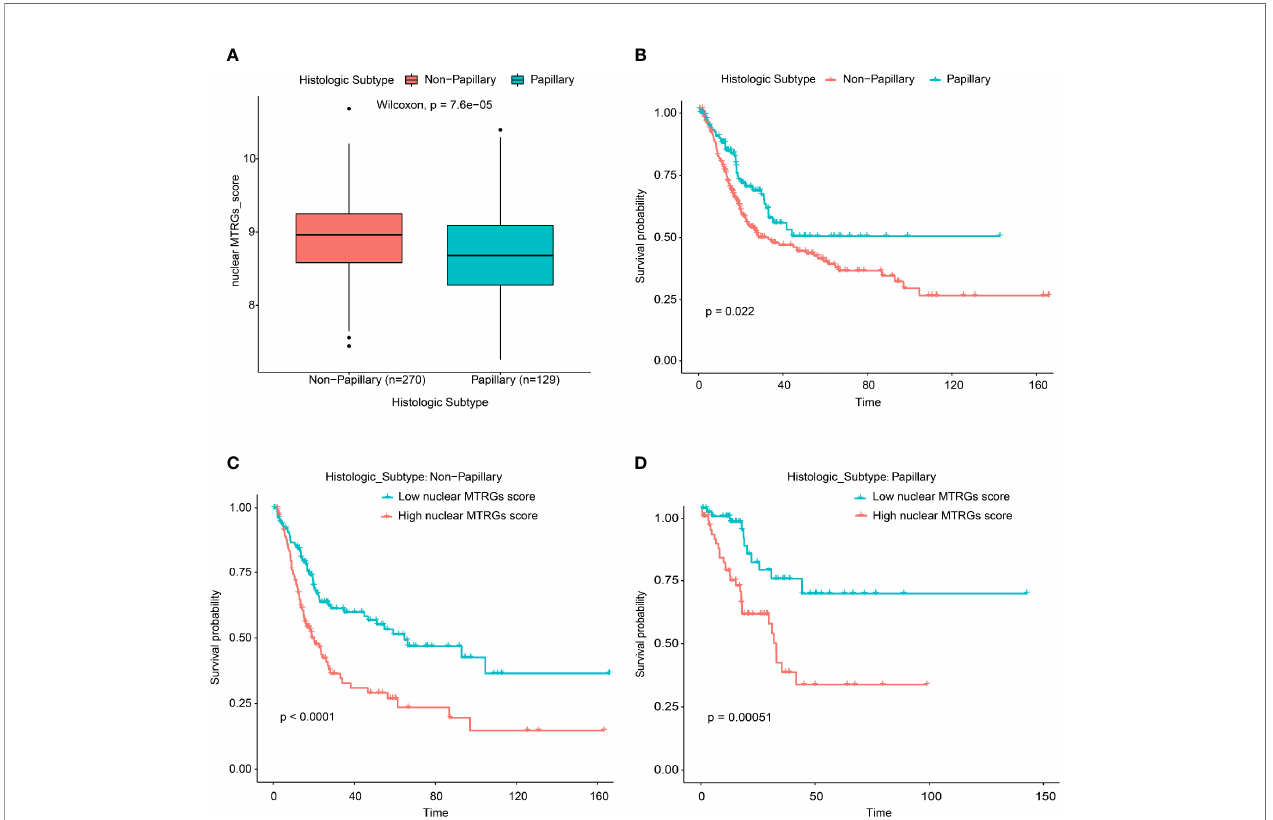
FIGURE 5 | Comparison of the nuclear MTRGs score between BC patients with or without the papillary features, and the survival analysis in the different histologic subtype